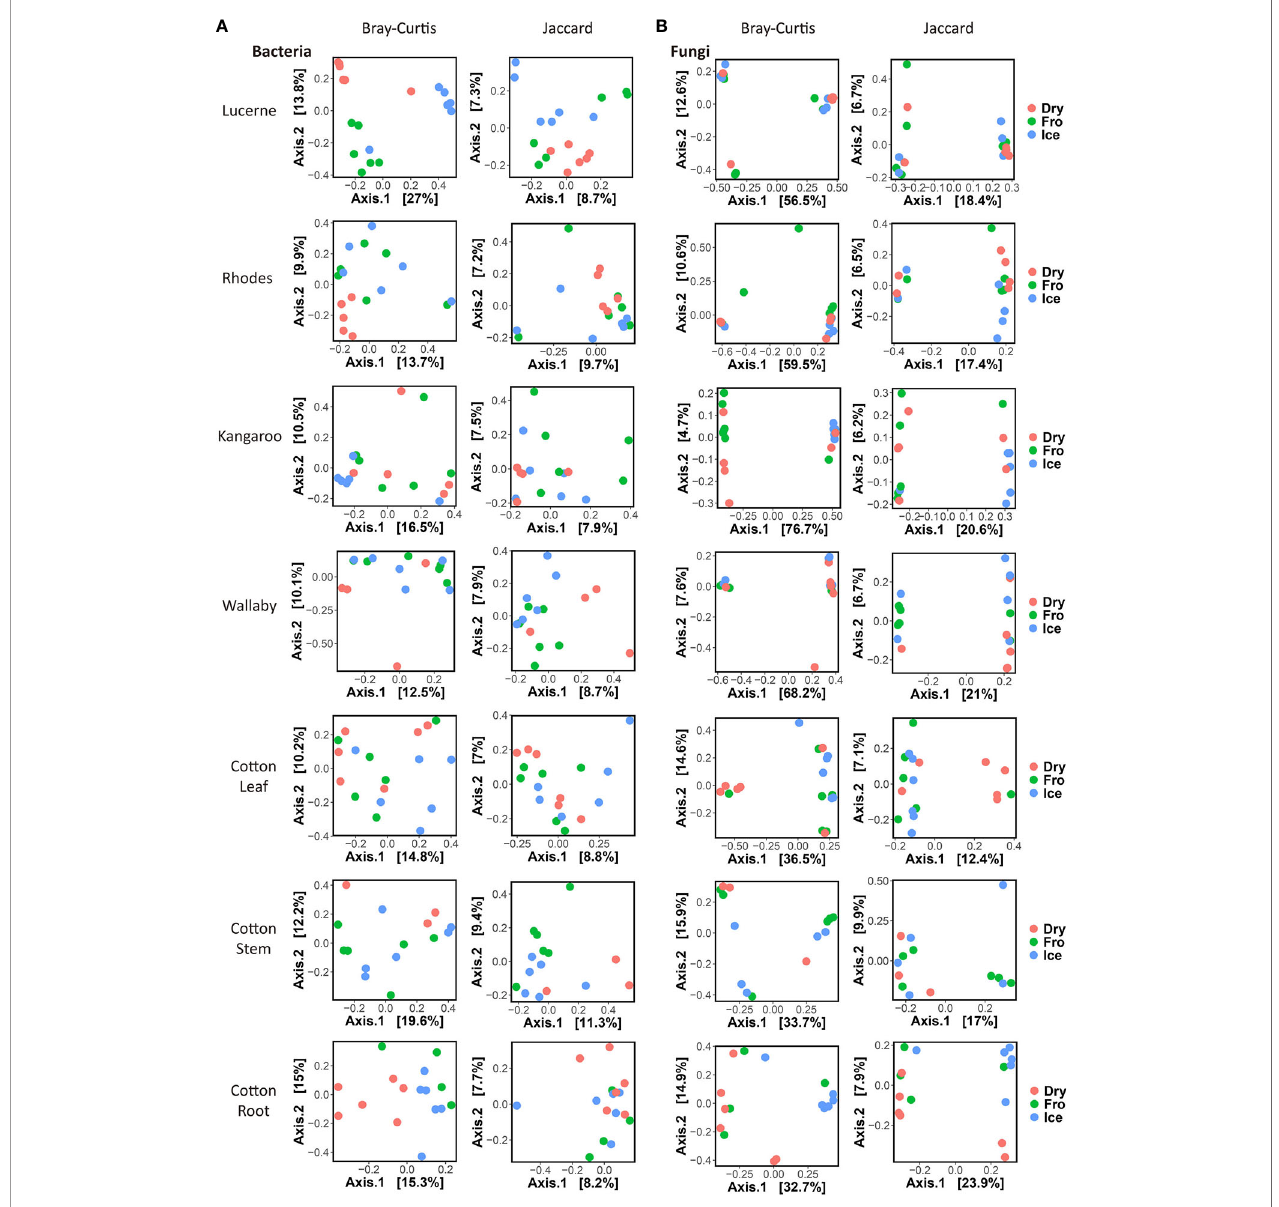
FIGURE 3 | Individual Principal Coordinates Analysis (PCoA) plot using Bray – Curtis and Jaccard distance matrix on bacterial (A) and fungal (B) communities under different preservation